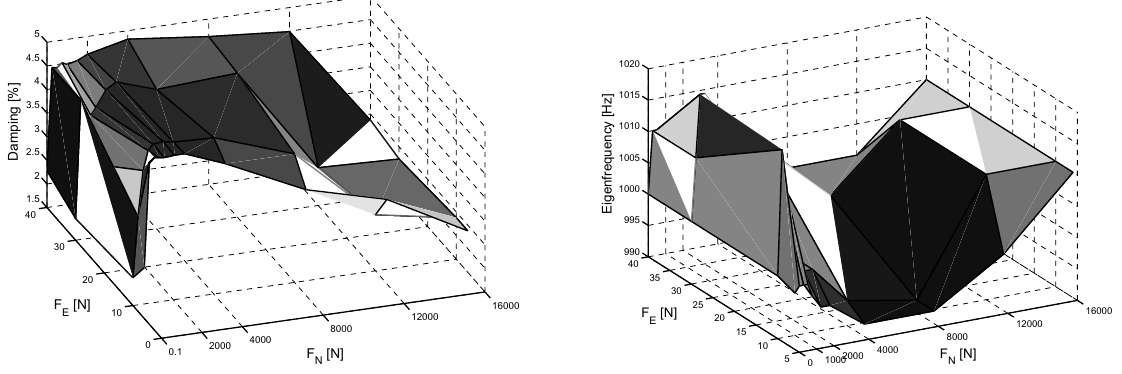
Fig. 9. Modal damping and eigenfrequency for the work piece table with friction beam at one side – mode